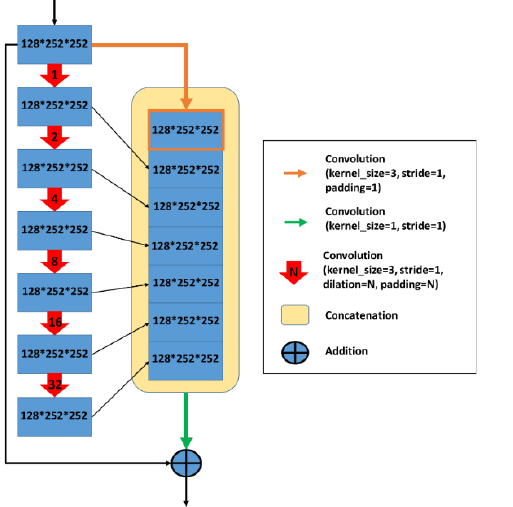
Figure 5. ResDilation block